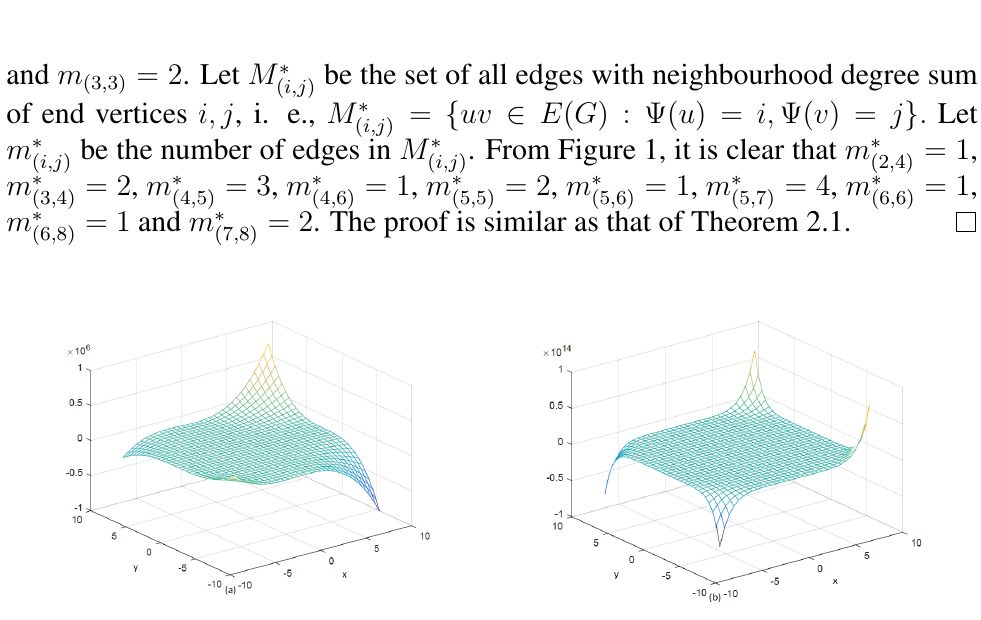
Figure 12: Plotting of (a) M-polynomial and (b) NM-polynomial of